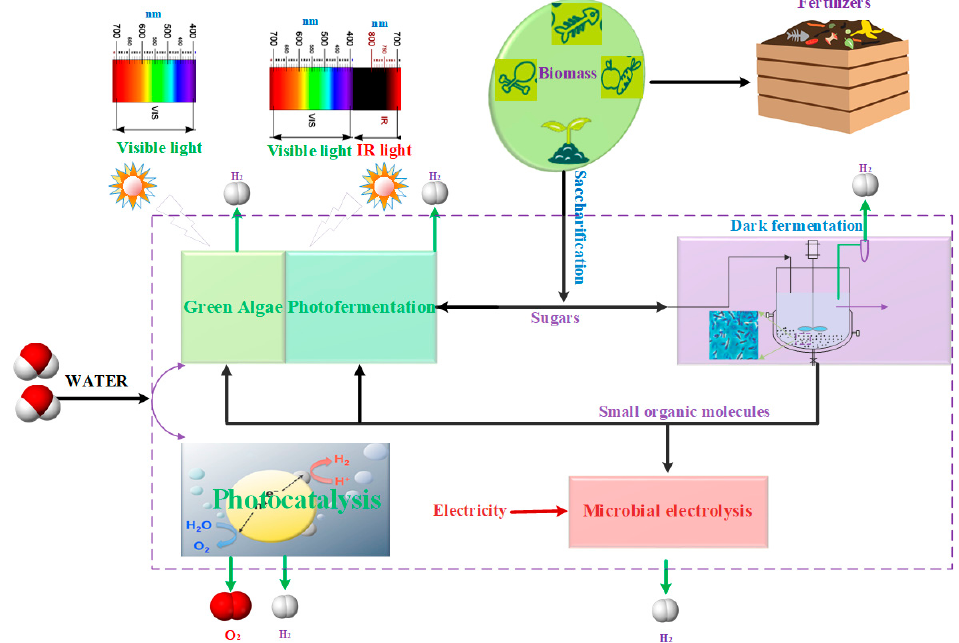
Figure 5. Simplified conceptual illustration diagram of an integrated and multi-coupling process of BHP (biohydrogen production) with photocatalysis using biomass as the substrate.